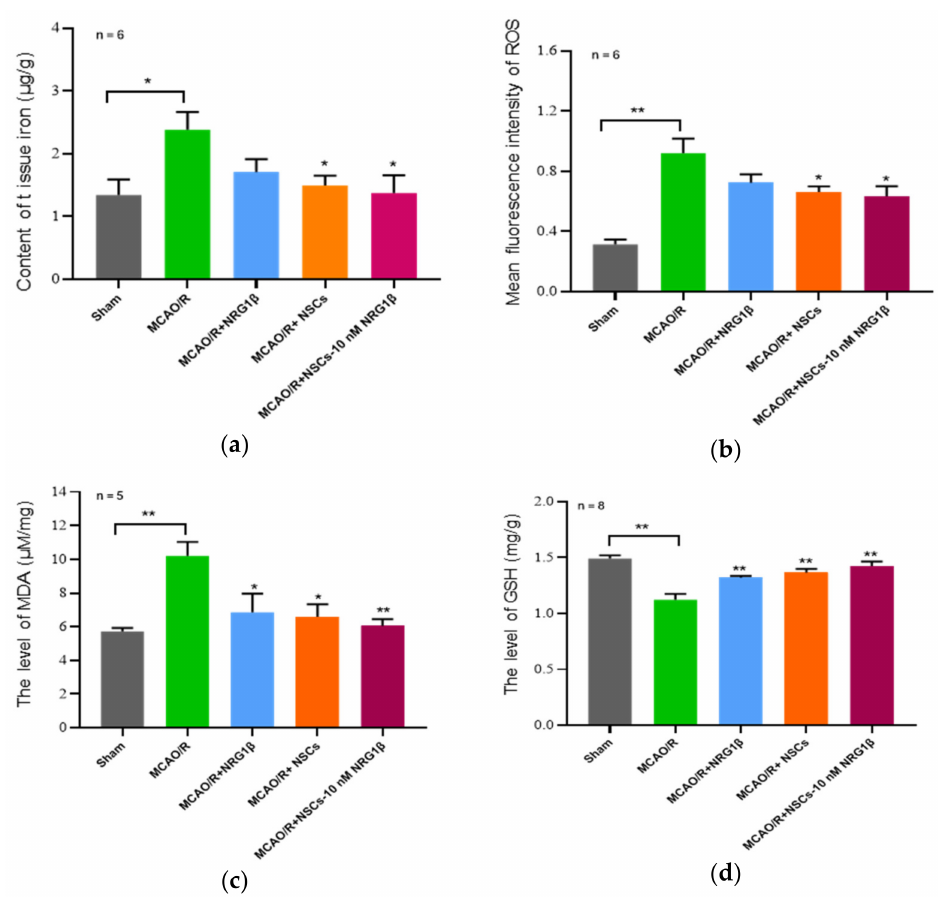
Figure 3. Effect of NSCs transplantation on ferroptosis indicators in ischemic cortex. ( a ) Contents of tissue iron ( µ g/g) in Sham, MCAO/R, MCAO/R+ NRG1 β , MCAO/R+NSCs, MCAO/R+ NSCs- 10 nM NRG1 β groups. ( b ) The level of ROS in different groups. ( c , d ) The expression of MDA and GSH in different groups. * p < 0.05, ** p <